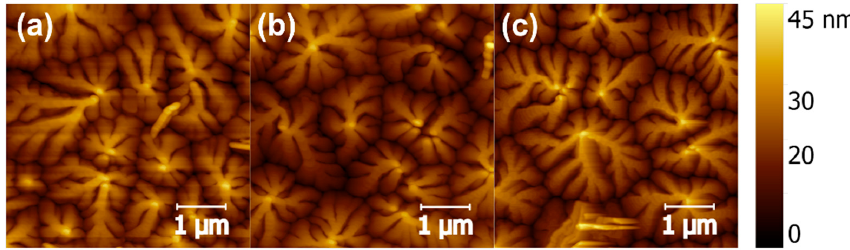
Figure 3. AFM height images of pentacene films deposited on three kinds of dielectics, ( a ) device A; ( b ) device B; and ( c ) device C. ( b ) device B; and ( c ) device